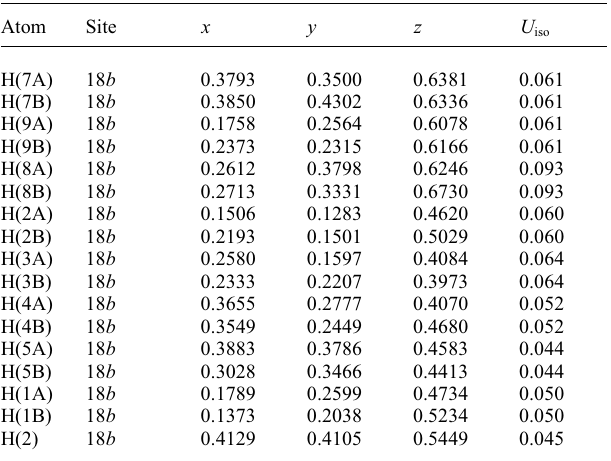
Table 2. Atomic coordinates and displacement parameters (in Å 2 ) . Atom